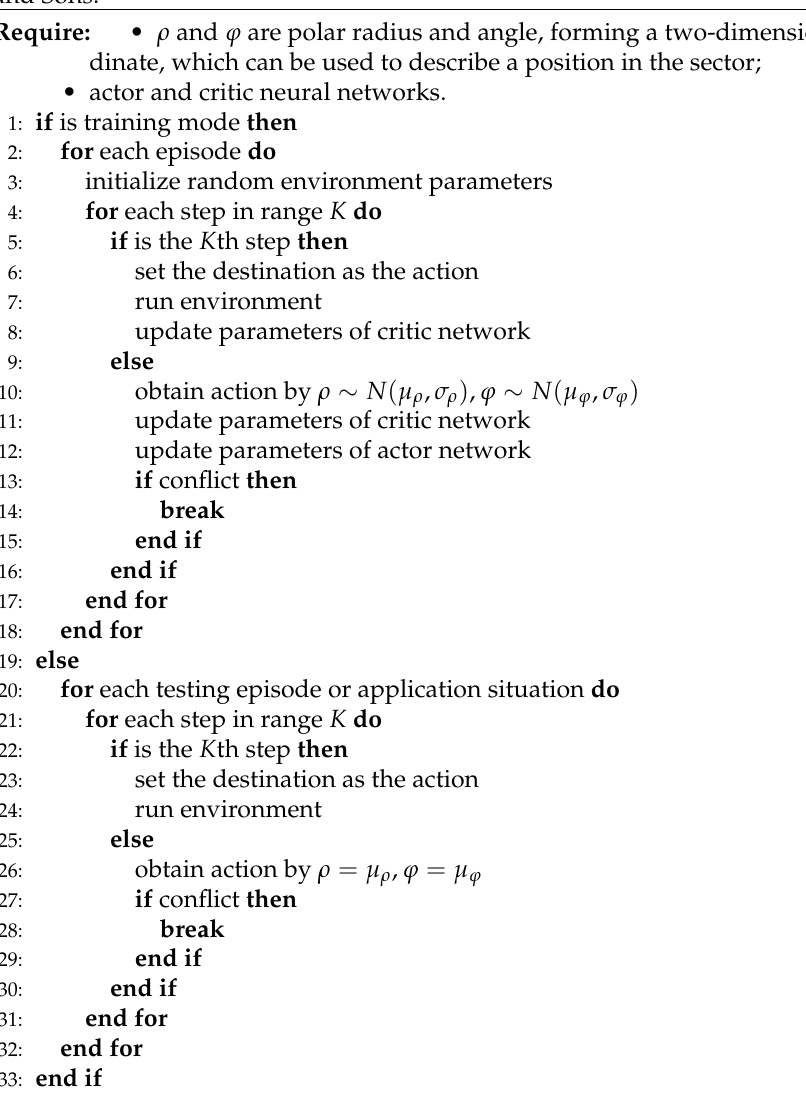
Algorithm 2 K-Control Actor-Critic. Reprint with permission from [33]. 2019, John Wiley and